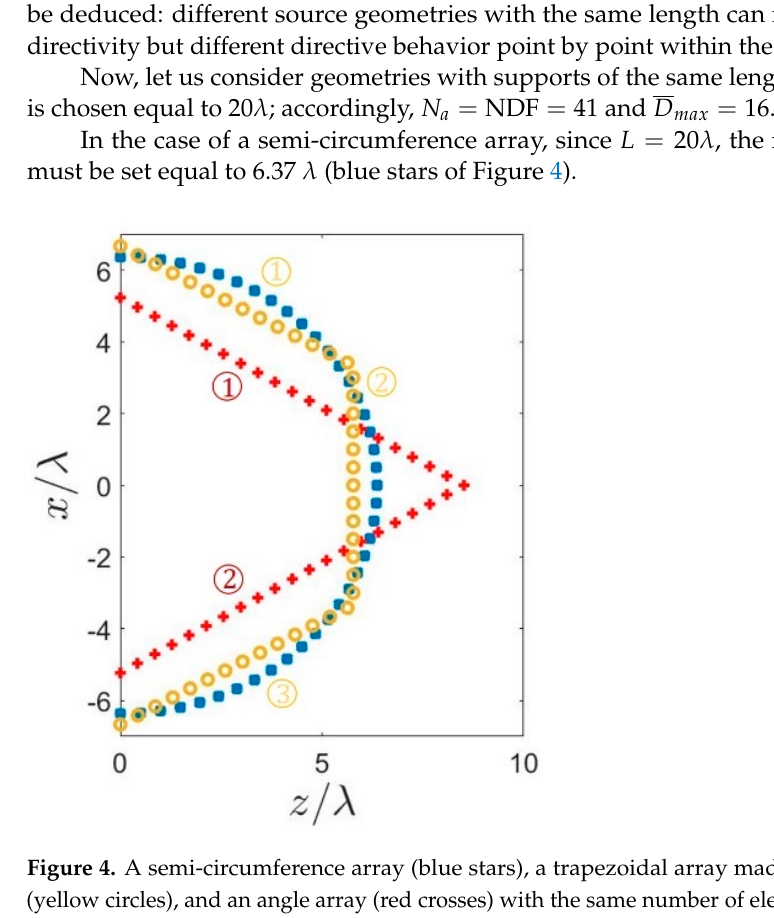
Figure 5. The behavior in dB of the maximum directivity D (cid:2923)(cid:2911)(cid:2934) (cid:4666)θ (cid:2868) (cid:4667) of the semi-circumference ar- ray (solid blue line) in Figure 4. The dashed line represents the corresponding value of 𝐷(cid:3365) (cid:3040)(cid:3028)(cid:3051) . Then, let us see if one can do better by approximating the semi-circumference shape with three rectilinear sources (the trapezoidal shape of Figure 4). To build an array of length 𝐿 with minimum discrepancy from a semi-circumference shape, the trapezoidal support must have segments of length 𝑎 (cid:2869) = 𝑎 (cid:2870) = 𝑎 (cid:2871) = 𝑎 = 3.33𝜆 which form the angles ϕ (cid:2868)(cid:2869) = 5π/6 , ϕ (cid:2868)(cid:2870) = π/2 , ϕ (cid:2868)(cid:2871) = π/6 with the 𝑧 -axis. In Figure 6, the 𝐷 (cid:3040)(cid:3028)(cid:3051) curve relative to the case when all the three linear arrays are active (blue line) and to the case when only the arrays 1 and 2 are turned on (dotted red line) is reported (the one referring to the combined action of the arrays 2 and 3 is a mirror curve of the latter). As can be seen, the combined action of the three linear arrays has the effect of increasing the achievable directivity around the θ (cid:2868) = 0 direction. However, even though the constrained hemispherical coverage is guaranteed, by keeping all the arrays active, Δ𝐷 (cid:3040)(cid:3028)(cid:3051) = 3.30 dB and σ (cid:2870) = 0.83 , namely, both the values are greater than the ones related to the semi-circumference array. Instead, if just one couple of arrays at a time is